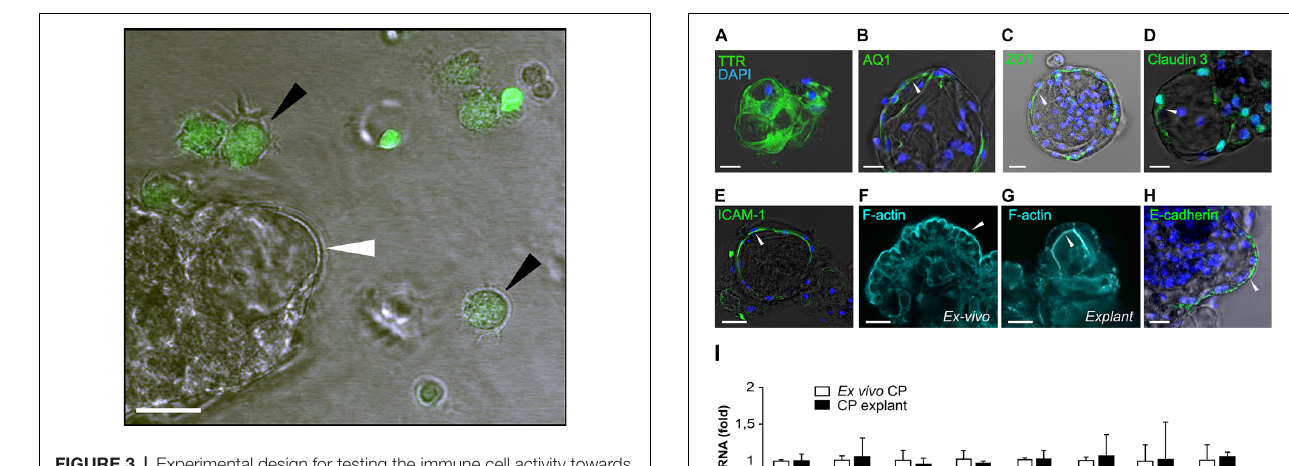
FIGURE 3 | Experimental design for testing the immune cell activity towards the explants (white arrow). Dendritic cells (DCs) are labeled green with fluorescent marker carboxyfluorescein succinimidyl ester (CFSE; black arrows; bar 20 µ m). qPCR data were analyzed using Wilcoxon matched-pairs signed rank-test to compare the data from different explant lines.